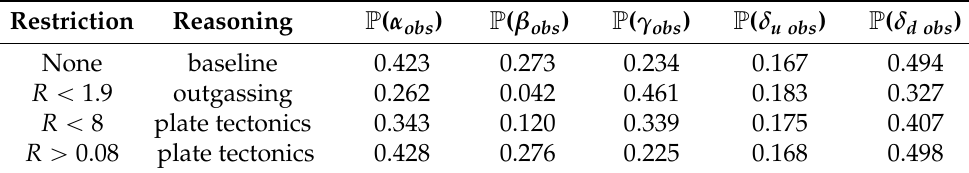
Table 2. The probabilities of observing the values of our physical constants for various metal-to-rock thresholds. All utilize the entropy and yellow habitability criteria. For a habitability criterion to be considered consistent with the multiverse hypothesis, all probabilities must be reasonably close to